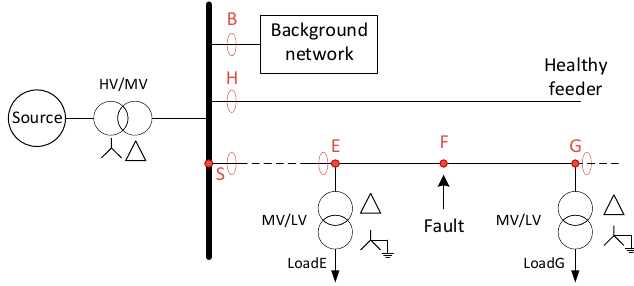
Figure 1. Distribution network with isolated neutral under earth fault condition.